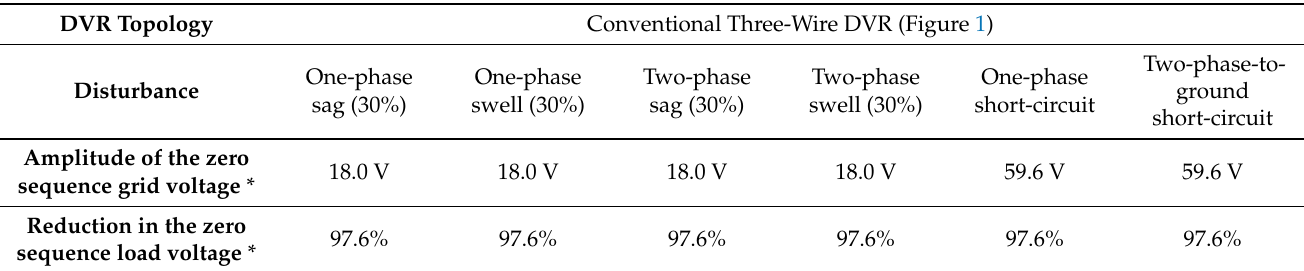
Table 4. Summary of the attenuation of zero sequence voltage for different faults being applied to the grid voltages (simulation